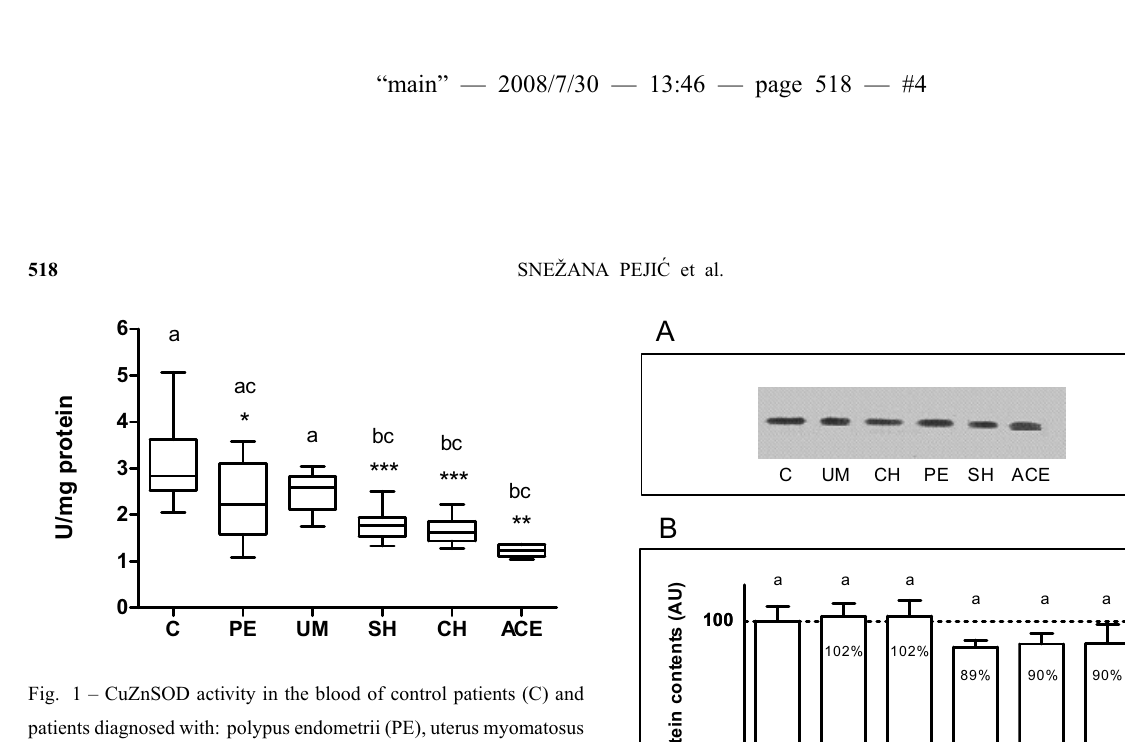
sia, levels of LOOH were higher than in patients with < . polypus (p 0